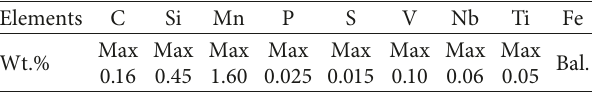
Table 1: Chemical components of X65 steel.